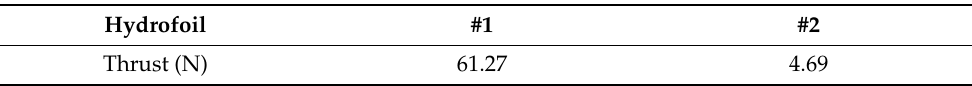
Table 8. Average values of T 1 and T 2 when wave height is 0.25 m and wavelength is 8